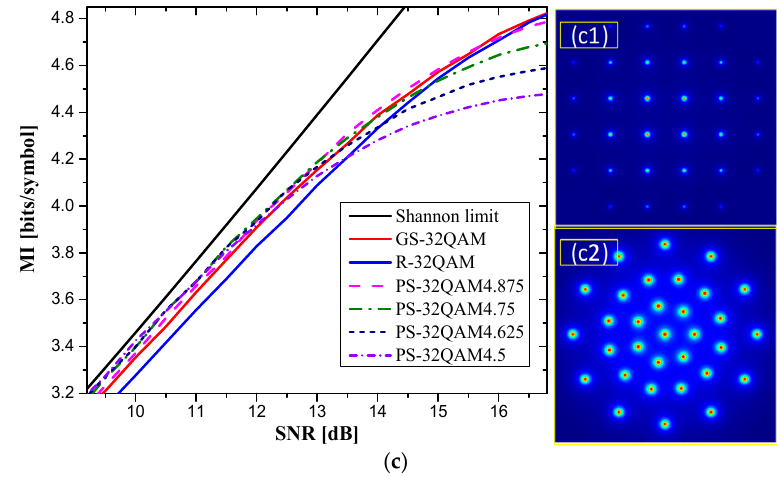
Figure 7. Mutual information (MI) versus signal-to-noise ratio (SNR) performance in Gaussian-noise- limited channels for ( a ) PS/GS/R-8QAM, ( b ) PS/GS/R-16QAM, ( c ) PS/GS/R-32QAM. Insets (a1,a2) The constellation diagrams of PS-8QAM and GS-8QAM. Insets (b1,b2) The constellation diagrams of PS-16QAM and GS-16QAM. Insets (c1,c2) The constellation diagrams of PS-32QAM and GS-32QAM.